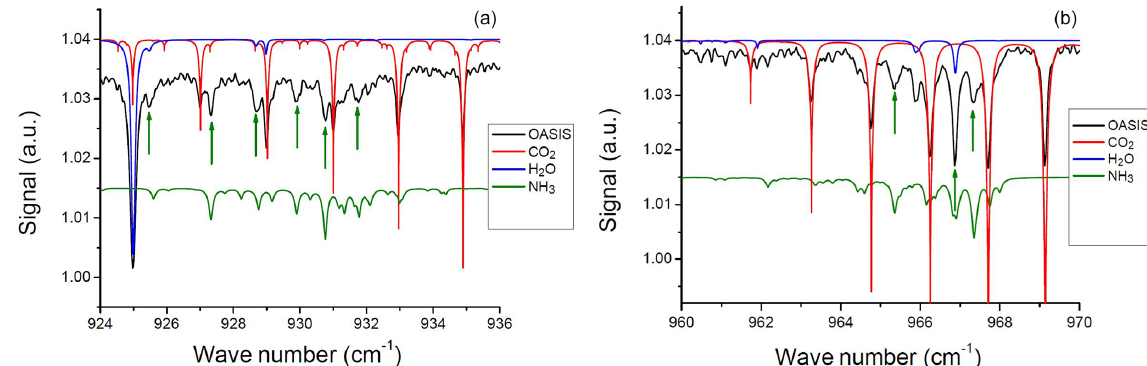
Figure 2. Measured spectrum for both spectral windows obtained with the Bruker Vertex 80 at Créteil on 21 March 2012, with individual contributions of the main absorbing species represented from the atlas by Meier et al. (2004) in the first (a) and second (b) spectral windows. Green arrows point out the strong ammonia